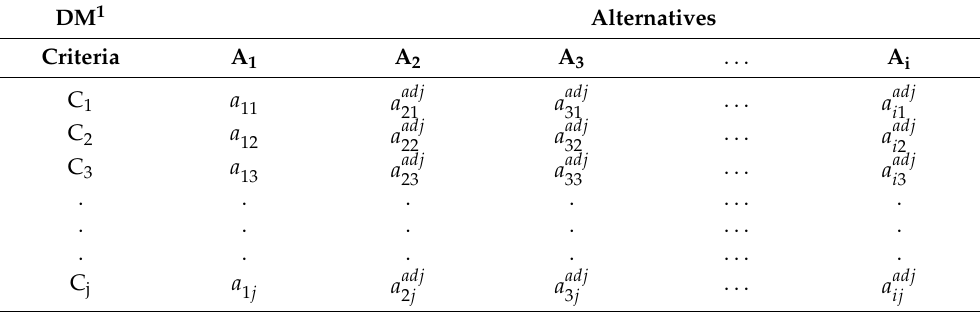
Table 4. Optimized MCDM matrix for DM